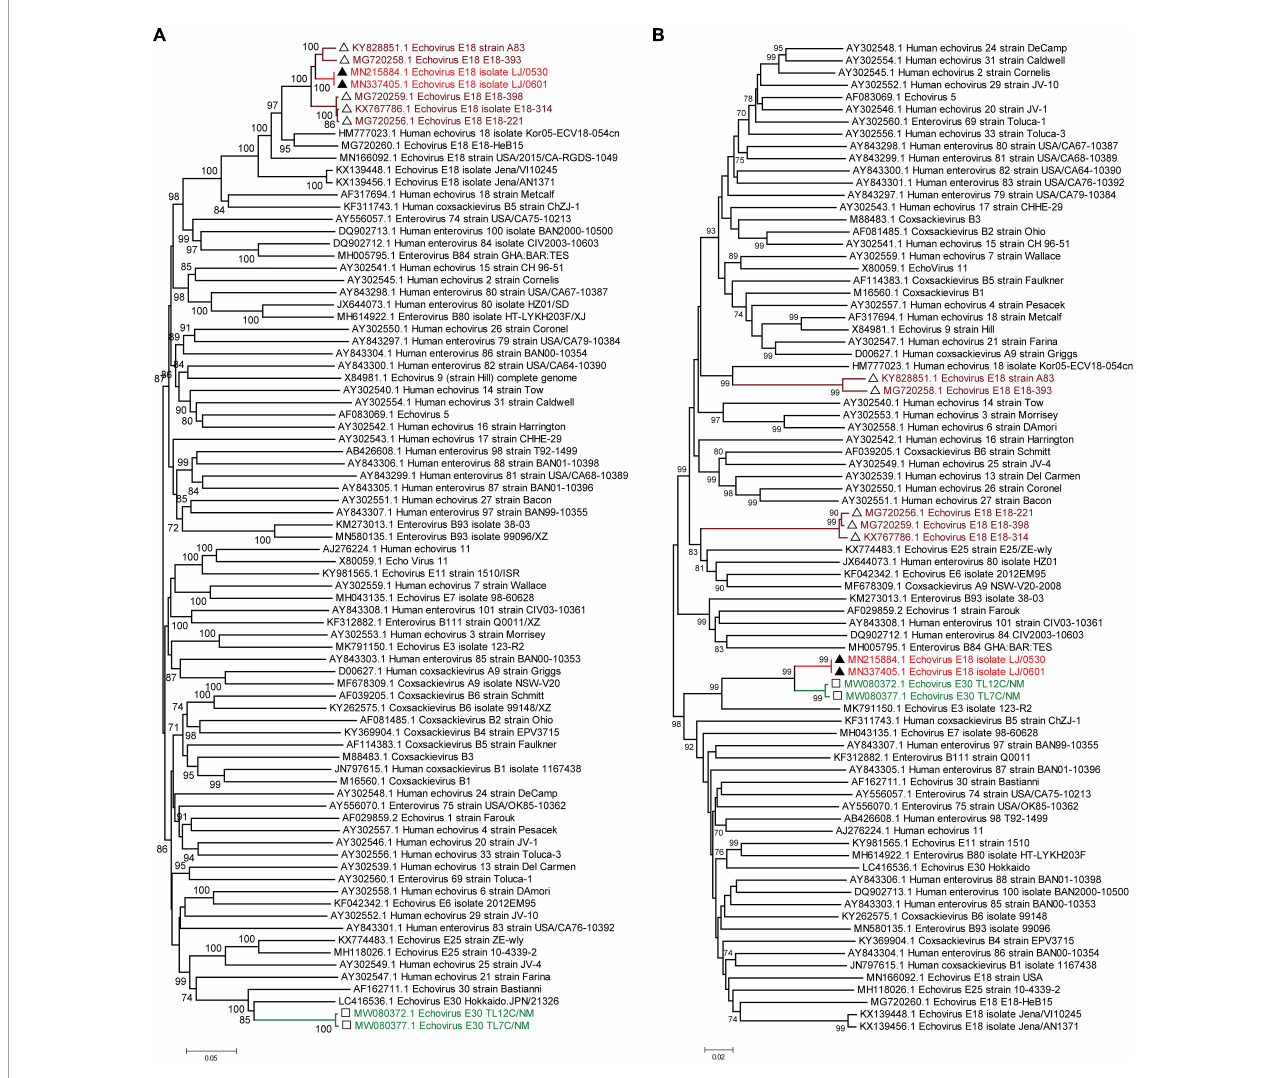
FIGURE3 Phylogenetic relationships based on the 5 (cid:48) UTR to 2A region and the 2B region to 3 (cid:48) UTR of EV-B strains. Panels (A,B) show the phylogenetic trees of the representative 5 (cid:48) UTR to 2A region (A) and the 2B to 3 (cid:48) UTR region of the EV-B strains. Numbers at the nodes indicate bootstrap support for that node (percentage of 1,000 bootstrap replicates). The scale bars represent the genetic distance. Red indicates the two strains in our study. Brown indicates the echovirus 18 strains that are highly homologous to our strains in the 5 (cid:48) UTR to 2A region. Green indicates the echovirus 30 strains that are highly homologous to our strains in the 2B region to 3 (cid:48)